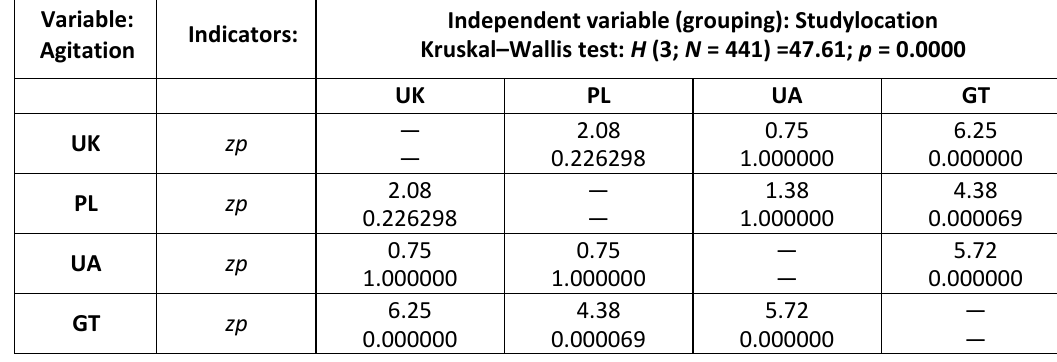
Table 7. Post-hoc tests for agitation